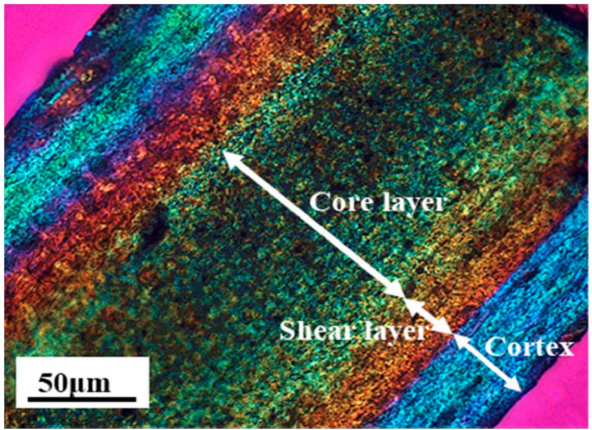
Figure 6. Polarized light micrograph of PVDF/GP micro-part (GP content: 1